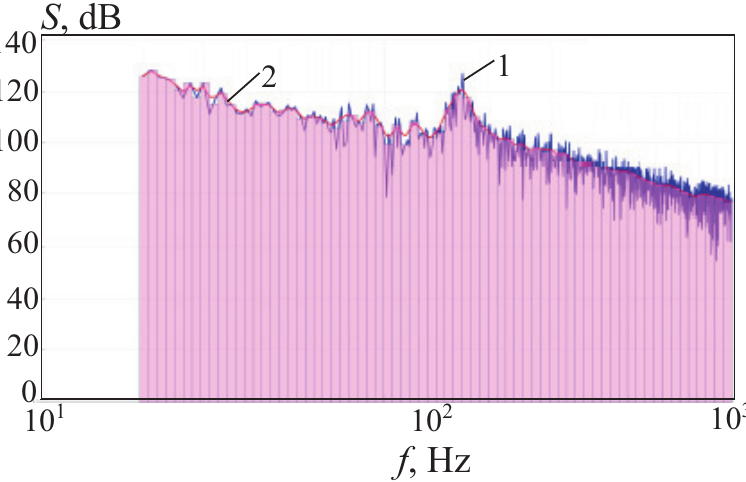
Figure 12. Spectrum of pressure fluctuations on the wall at point ( 0.1,0,0 )